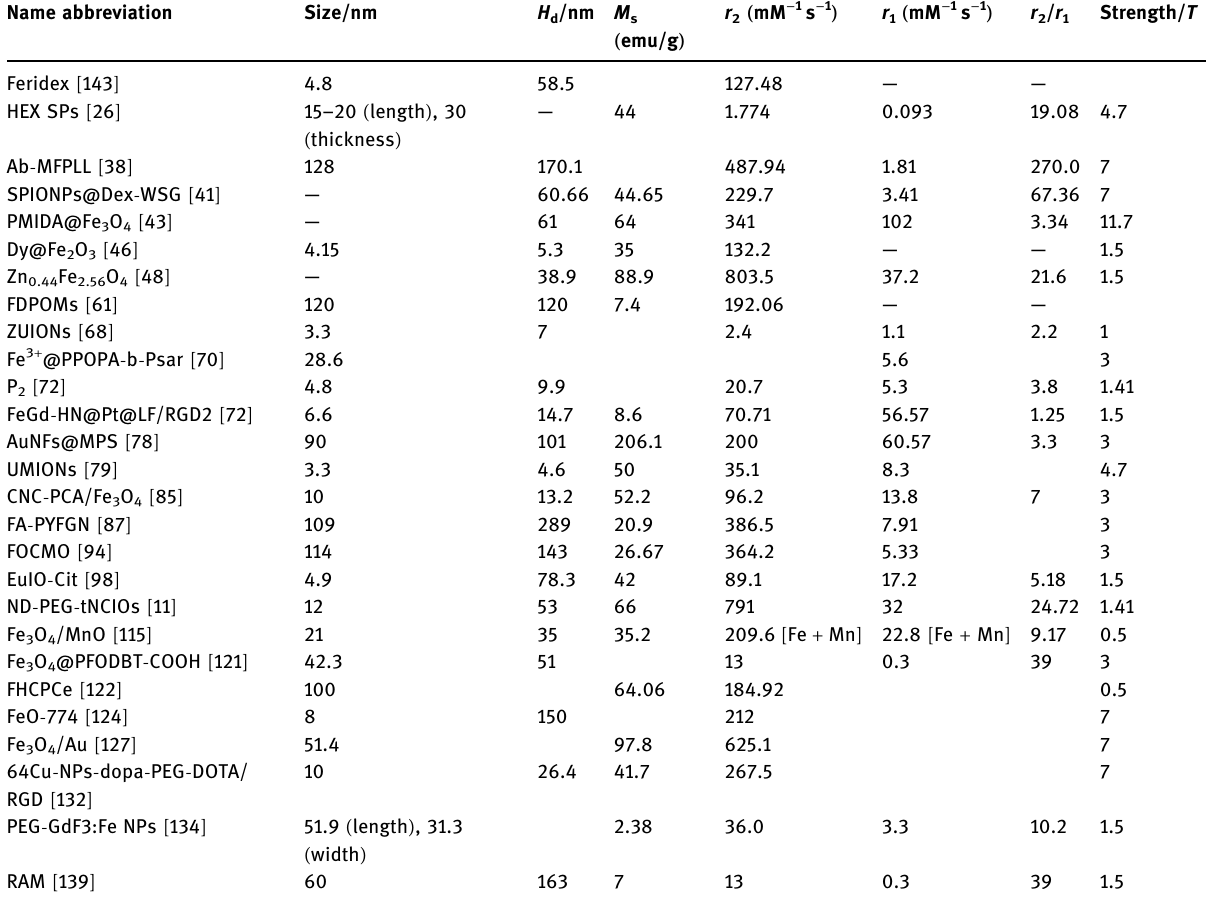
Table 1: Fe 3 O 4 NPs - related data of application in MRI Name